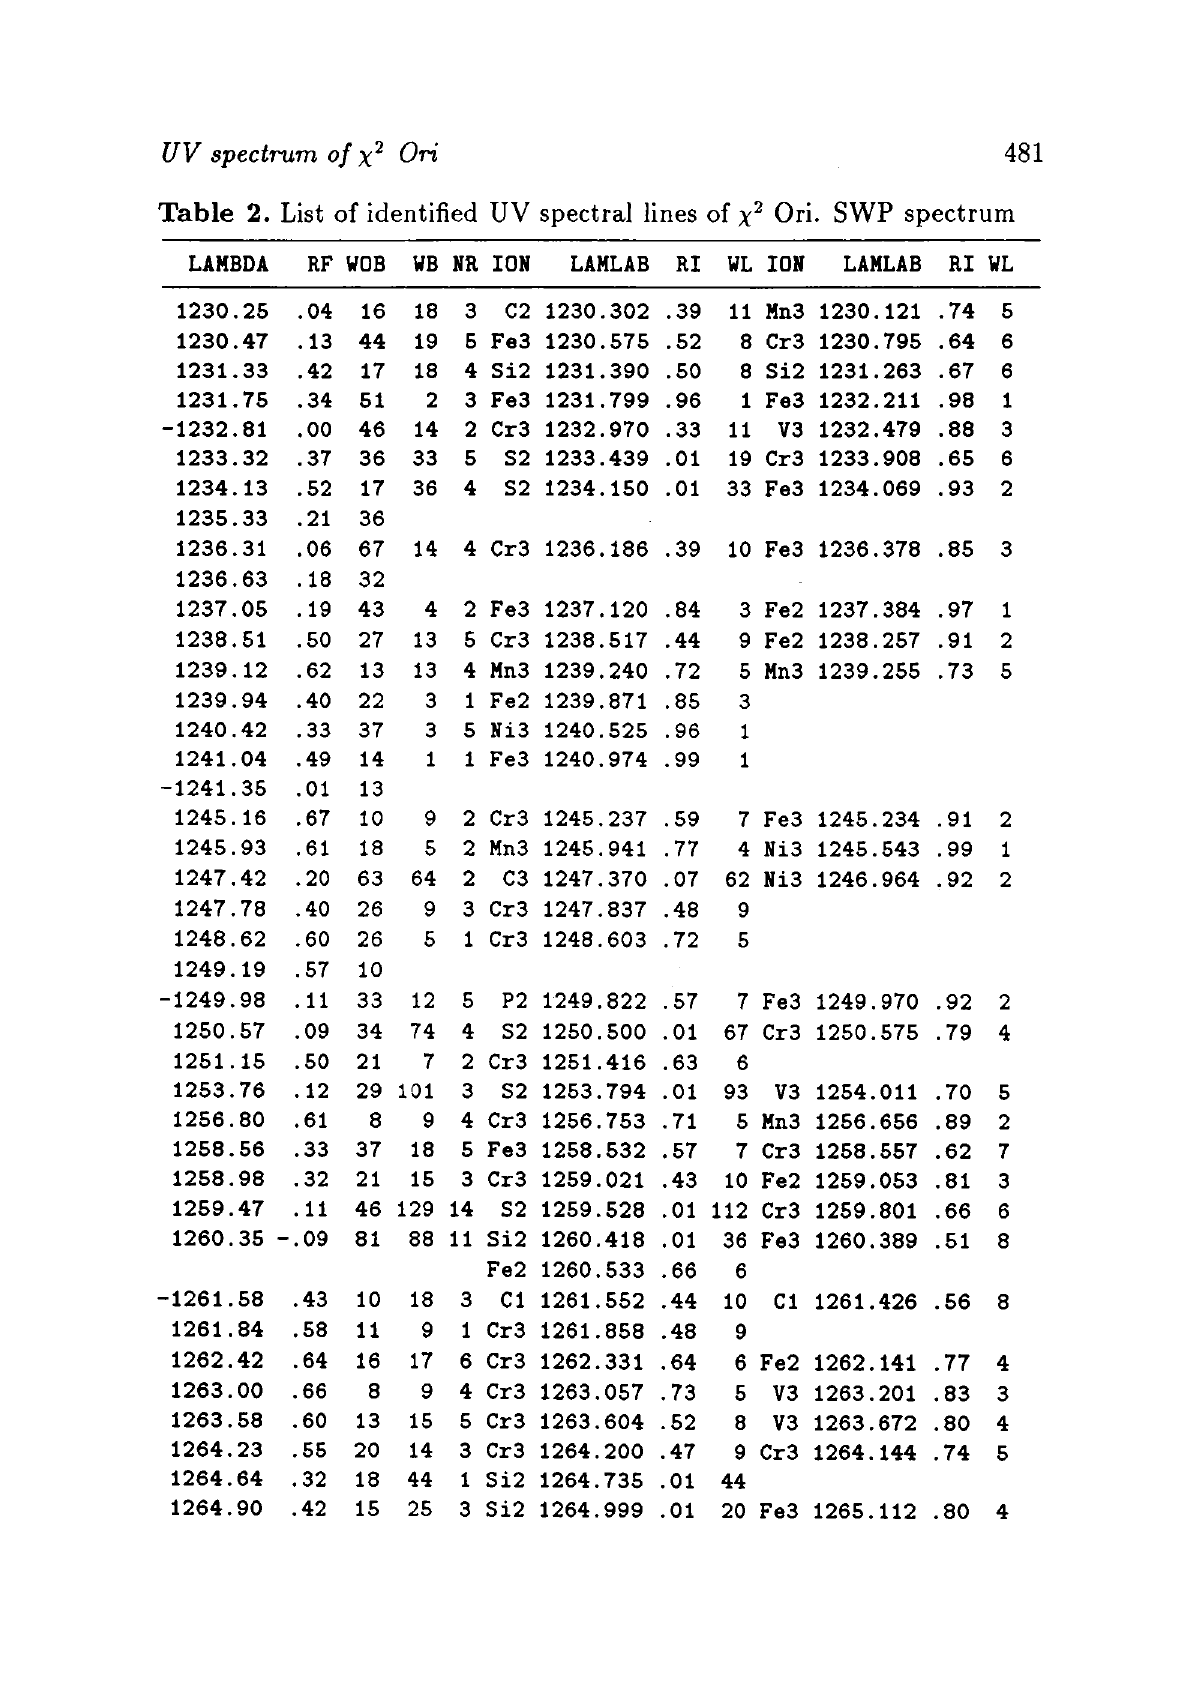
Table 2. List of identified UV spectral lines of x 2 Ori. SWP